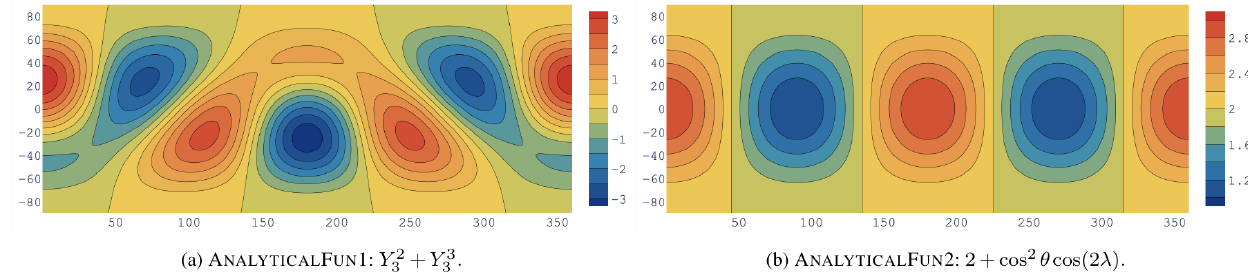
Figure 3. Contour plots of analytical fields used in this study: A NALYTICAL F UN 1 (a) and A NALYTICAL F UN 1 (b) .